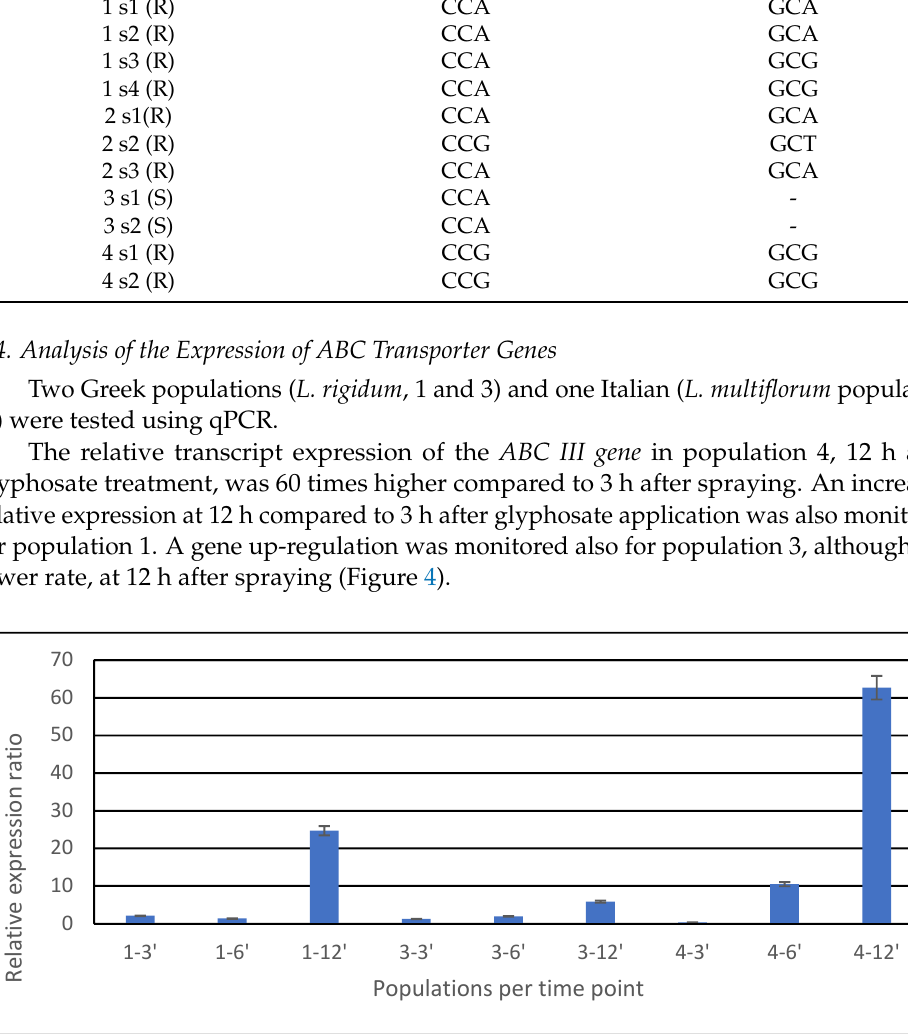
Figure 3. Nucleic acid sequences alignment of the 4 populations studied. CCA silent mutation is highlighted in yellow. CCG silent mutation is highlighted in green